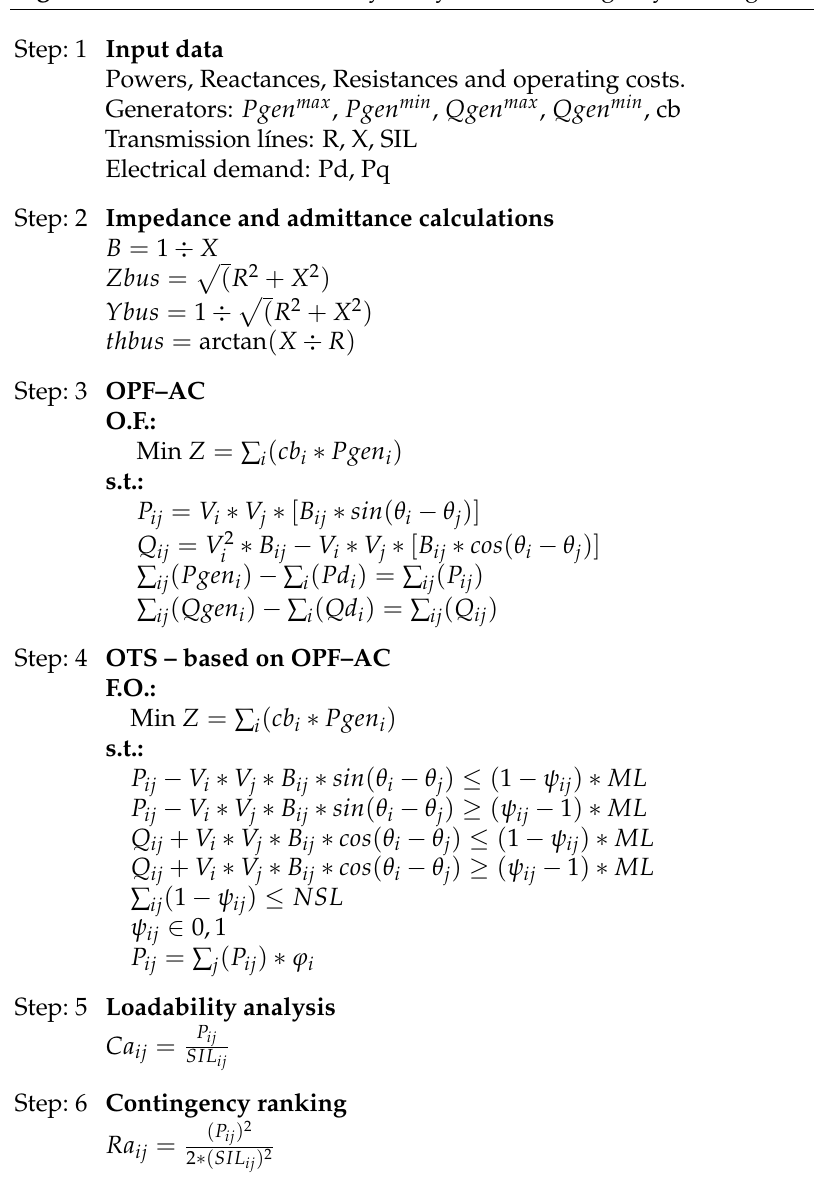
Algorithm 1 OST with loadability analysis and contingency